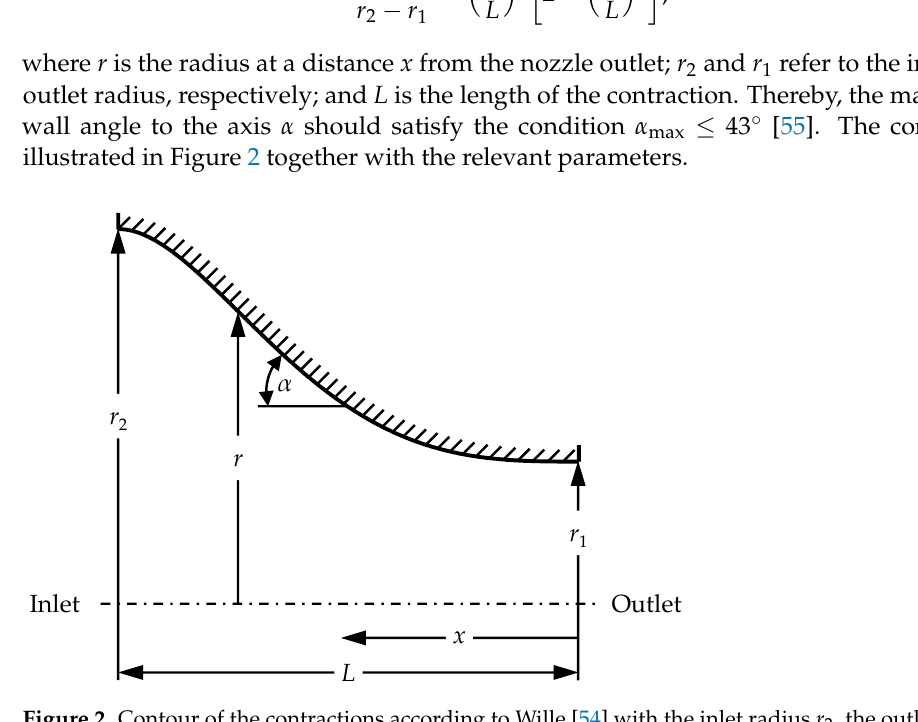
Figure 2. Contour of the contractions according to Wille [54] with the inlet radius r 2 , the outlet radius r 1 , the length of the contraction L , the maximum wall angle to the axis α , and the radius r at a distance x from the nozzle outlet. Table 1. Parameters describing the geometry of the contraction.